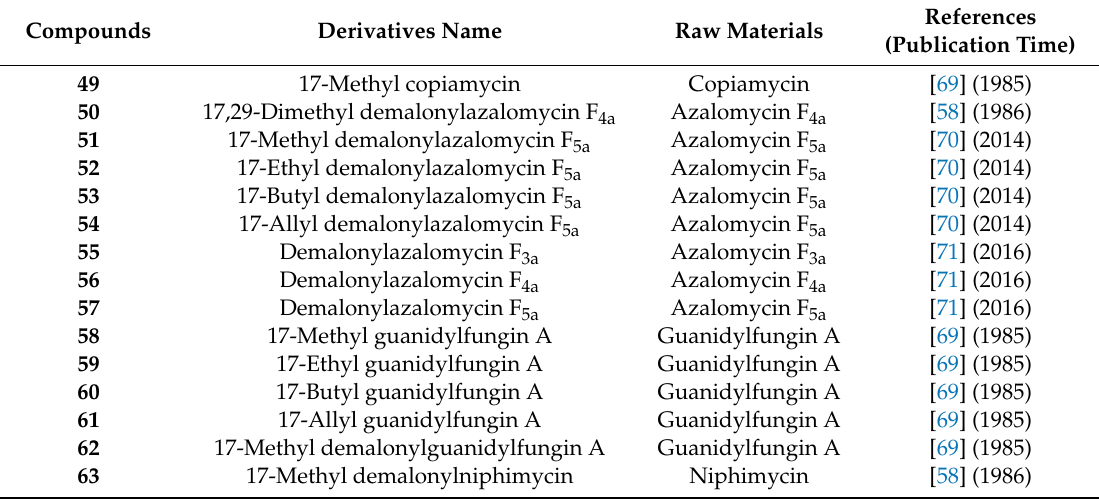
Table 2. Structural derivatives ( 49 – 63 ) of some guanidine-containing polyhydroxyl macrolides. Compounds Derivatives Name Raw